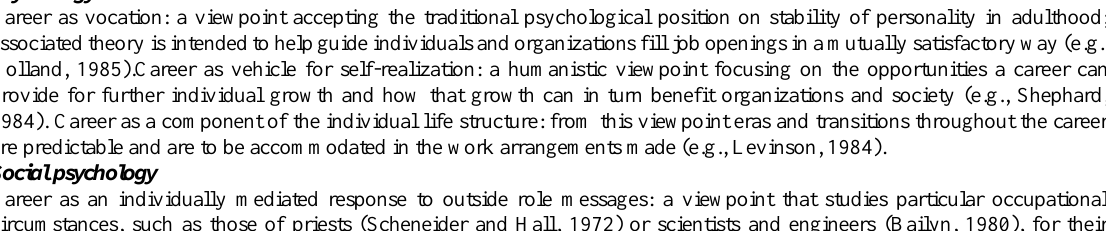
Table 1: Examples of Social Science Perspectives on the Career Concept